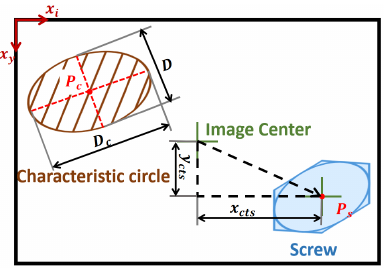
Figure 10. Initial image of the characteristic circle and a screw, where ox i y i denotes the image coordinate system; P c and P s represent the centers of the characteristic circle and screw, respectively, which can be roughly located in the image plane of a camera; D and D c denote the pixel lengths of the major and minor axes of the elliptical edge of the characteristic circle image, respectively; x cts and x cts denote the pixel distances along x and y coordinate axes from the image center to the screw center, respectively.